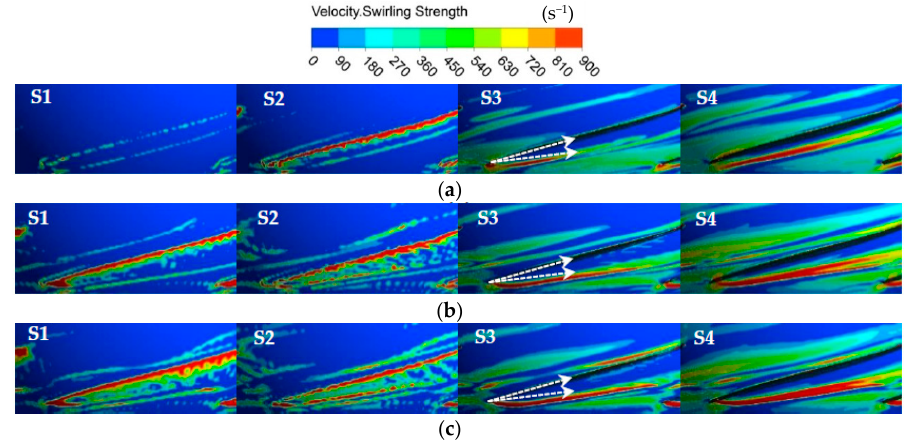
Figure 17. Comparison of TLV trajectories based on numerical and experimental results at different flow rates. λ is blade chord fraction, r is radius [42]. ( a ) 0.85 Q d ; ( b ) 1.0 Q d ; ( c ) 1.2 Q d . EXP: experiment results; SST: simulation results using shear stress transport.